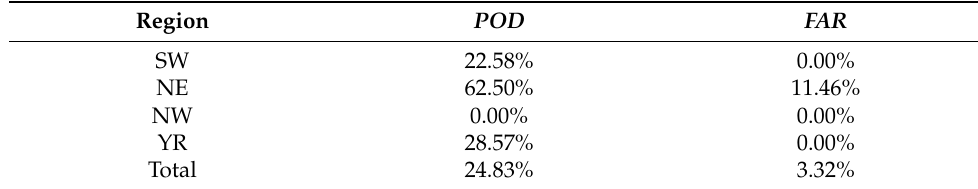
Figure 5. The comparison of the drought events determined by the local meteorological drought data and the drought characterization approach based on GRACE-DSI during 2006~2015 (the red bars represent the drought severity, orange bars represent the drought area percentage, and the gray bars represent the drought duration determined by the local meteorological drought data). Table 4. The POD and FAR of the drought characterization approach in four different